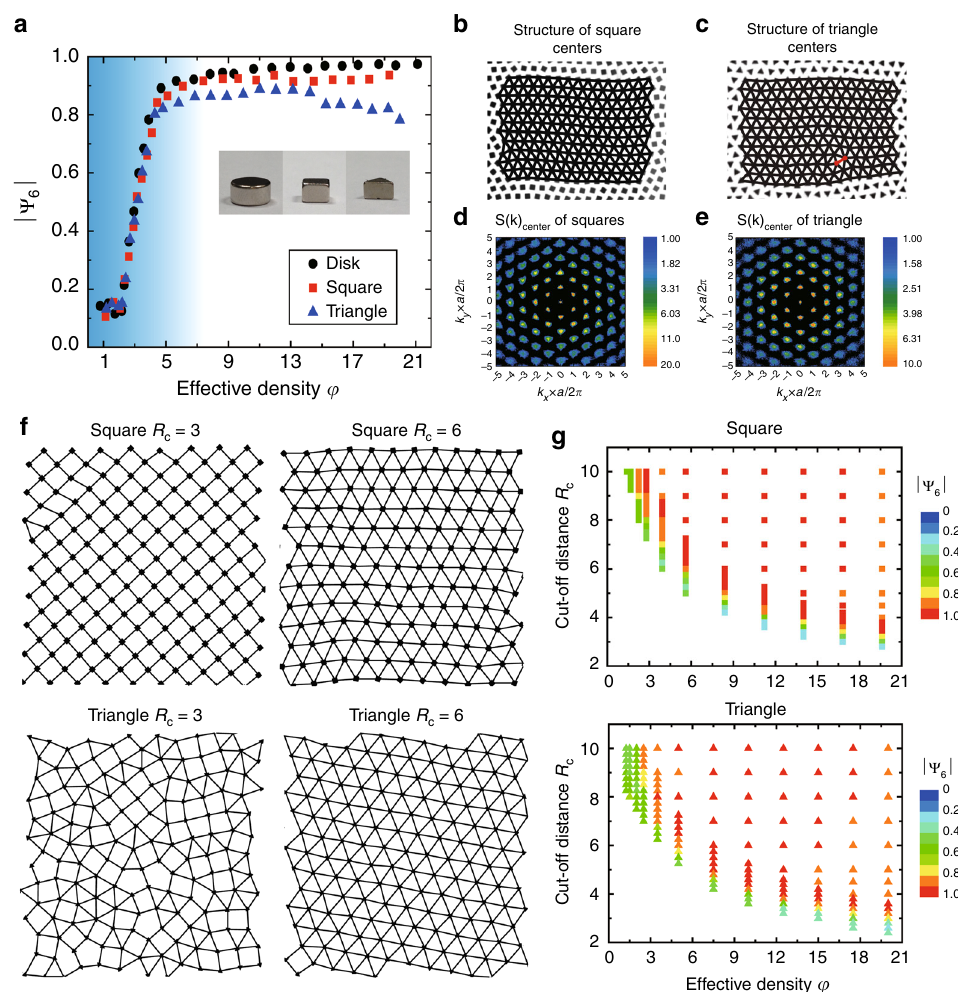
Fig. 1 A universal state in different polygonal systems. a The global bond orientational order parameter | Ψ 6 | calculated from all particle centers versus particle density φ for high-symmetry (discs), intermediate symmetry (squares) and low-symmetry (triangles) particles. For all three groups, the system is disordered at low densities but ordered at high densities. b and c a universal hexagonal state is formed by particle centers in both square and triangle systems. We connect all particle centers to give a better illustration. The effective area densities are φ = 16.8 and φ = 14.2, respectively. d , e Fourier transform of particle centers in c and d . The length scale a is the average particle distance. f numerical simulations of squares ( φ = 17.6) and triangles ( φ = 15) illustrate that the states are shape dependent at a low cut-off distance but shape-independent at a high cut-off distance. Upper panels: square particles produce a square lattice at low cut-off distance R C = 3 (the unit of R C is the disc particle ’ s diameter, i.e., 6 mm); while a hexagonal state appears at high cut- off distance R C = 6. Lower panels: triangle particles exhibit a glassy state at R C = 3 but a hexagonal state at R C = 6. g square and triangle particle ’ s phase diagrams from simulations. At large enough R C , a hexagonal state universally appears. The lower-left blank area is the region at and below the jamming point, where the system starts to unjam and fall